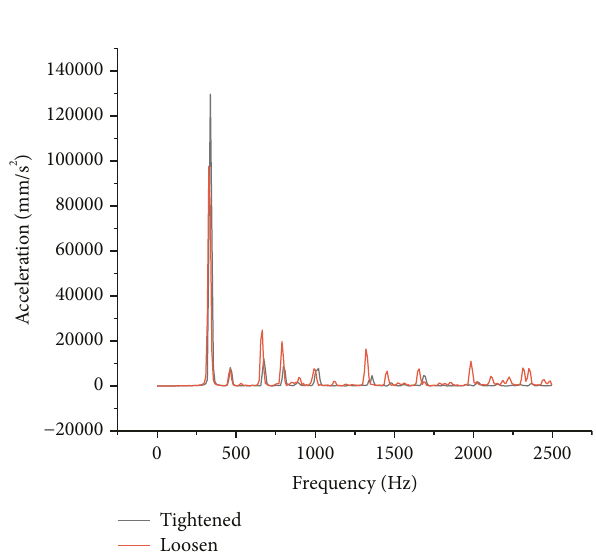
Figure 23: Amplitude-frequency curve.